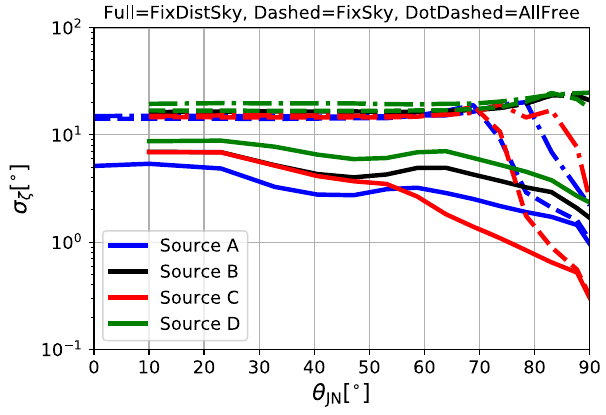
FIG. 1. Viewing angle uncertainty as a function of the binary inclination angle.